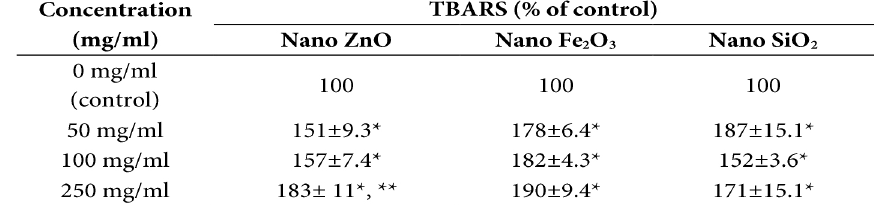
Table 1. TBARS level of RBCs after 24 h exposure to ZnO, Fe